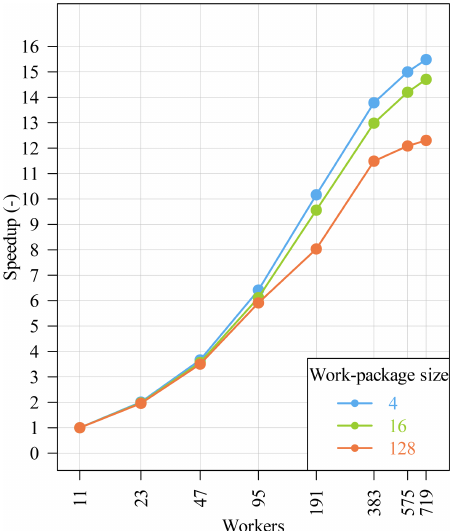
Figure 13. Speedup with respect to the reference simulation with 11 workers and active